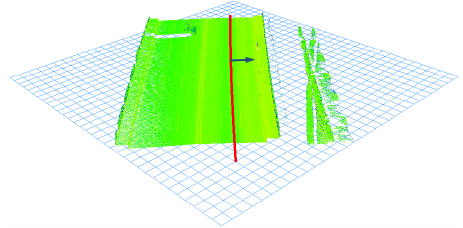
Figure 5. 3D points are assigned to the corresponding grids based on their X and Y coordinates. The red line is the trajectory. Along the arrow that indicates the orthogonal direction of the trajectory, the curbs are searched for.